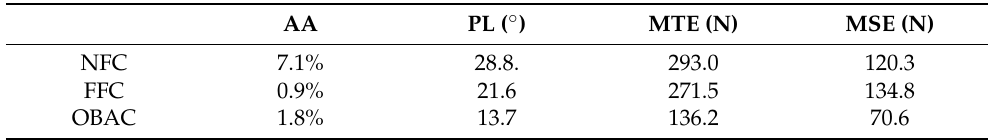
Figure 7. Dynamic loading experiment results (out-of-phase operation for tested EMA). Table 4. Performance indexes for the dynamic loading experiment (out-of-phase operation for tested EMA).